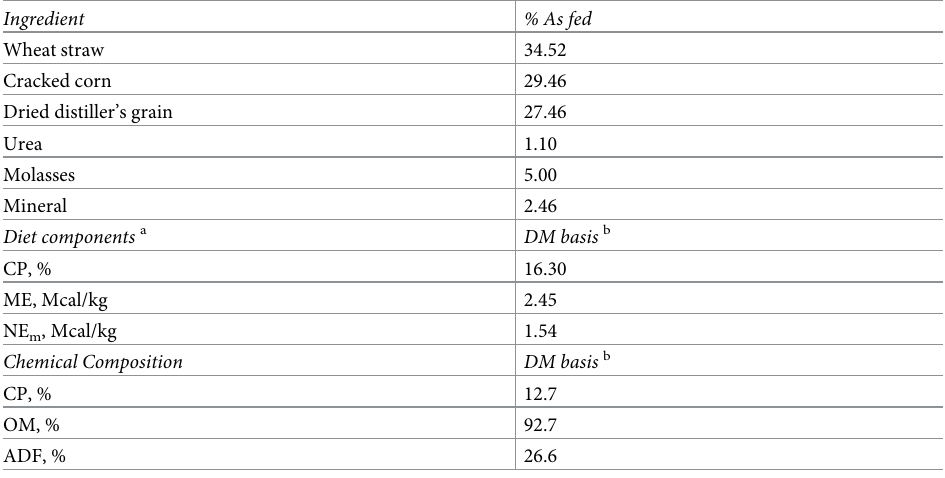
Table 1. Formulated ingredient and nutrient composition of diet fed to dams from gestational day 158 to